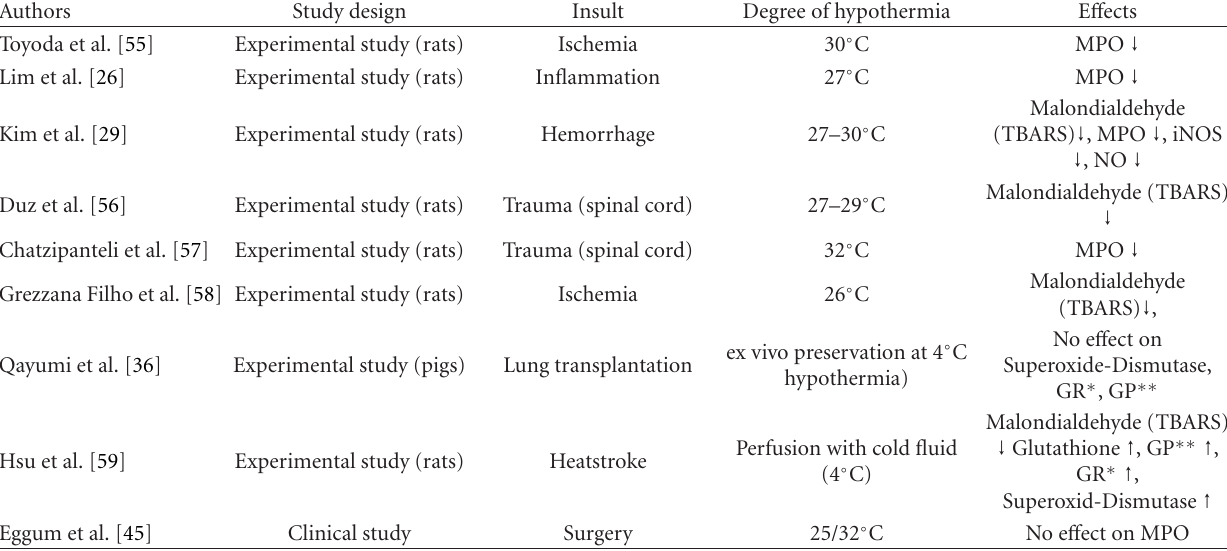
Table 6: E ff ects of hypothermia on proteins/molecules associated with the production of reactive oxygen